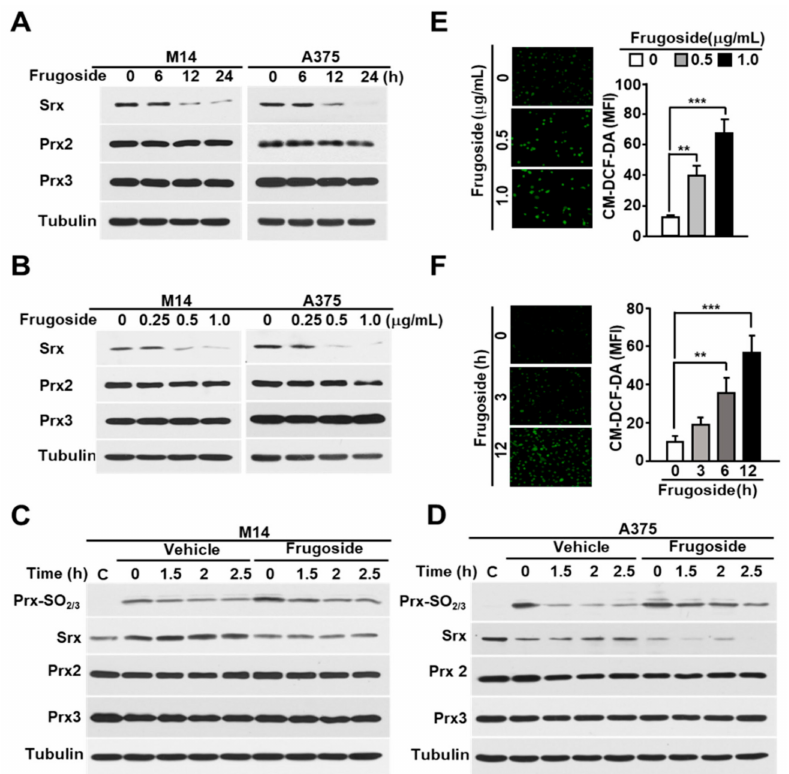
Figure 1. Frugoside inhibits Srx expression, leading to the hyperoxidation of Prxs caused by reactive oxygen species (ROS) accumulation. ( A , B ) Melanoma M14 and A375 cells were treated with frugoside in ( A ) time-dependent (0.5 µ g / mL) and ( B ) dose-dependent manners for 24 h, and the cells were subjected to a western blot analysis with antibodies against Srx, cytosolic Prx (Prx2), mitochondrial Prx (Prx3), and the loading control, tubulin. ( C , D ) M14 ( C ) and A375 ( D ) cells were treated with 200 µ M H 2 O 2 for 10 min with 0.5 µ g / mL frugoside. After 10 min, H 2 O 2 was washed out, and cells